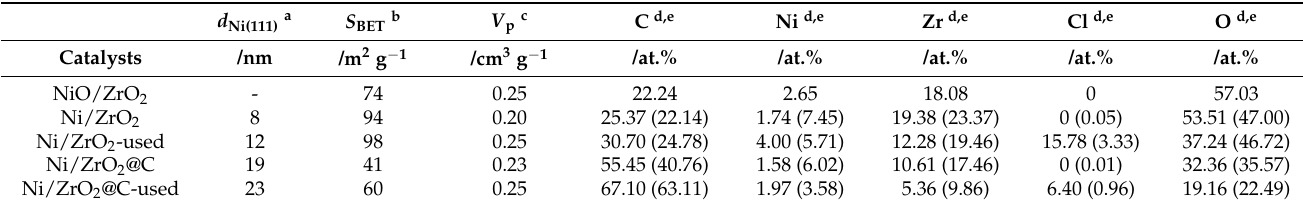
Table 1. Characterization data of the fresh and used catalysts.